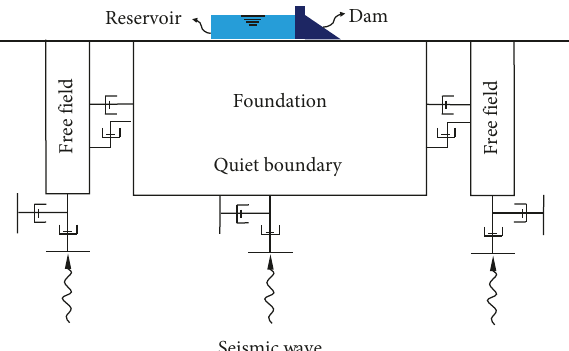
Figure 9: Boundary conditions for the finite difference model.